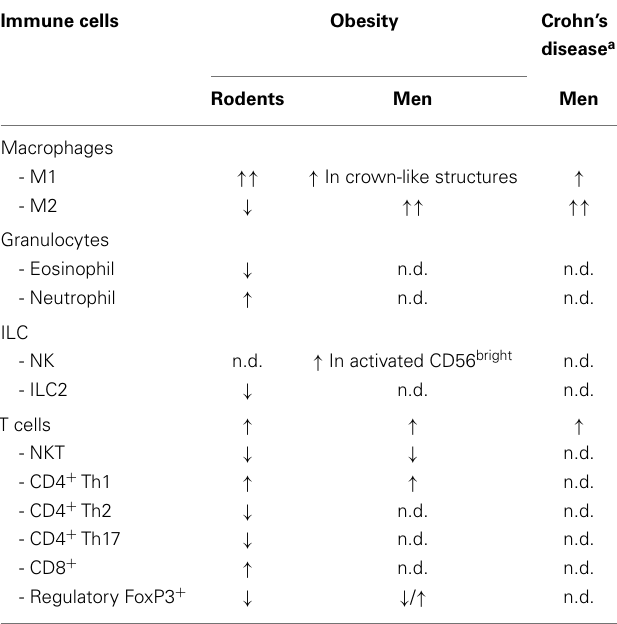
Table 2 | Immune-cell characterization in obesity versus Crohn’s disease